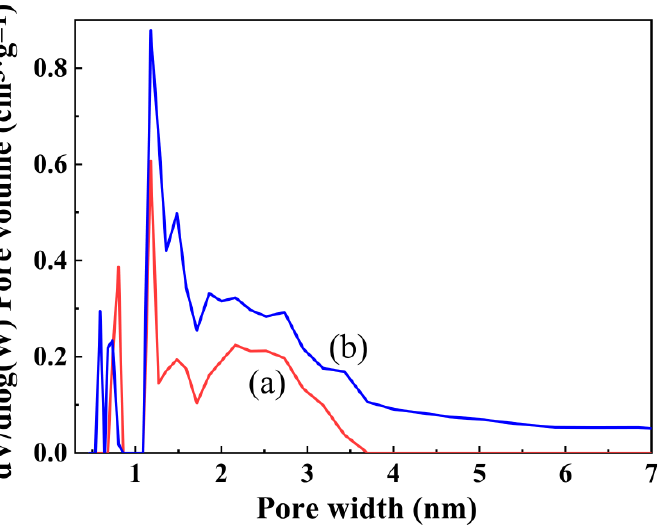
Figure 7. The corresponding pore size distribution curves for the (a) hydrophilic and (b) hydrophobic ZrO 2 -SiO 2 xerogels. Table 1. Pore structure parameters of the hydrophilic and hydrophobic ZrO 2 -SiO 2 xerogels.